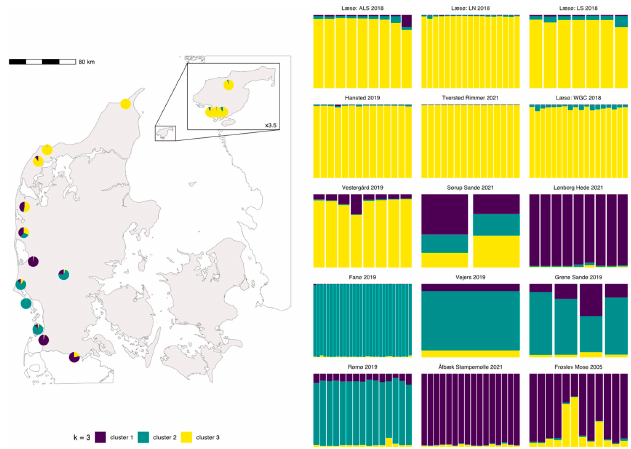
Figure 5. Results of genetic clustering analysis of the contemporary dataset in Structure for k = 3. The dataset included four loci. The bar plots show an individual’s probability of belonging to each of the three clusters and the pie charts on the map show the means of all individuals of each population.